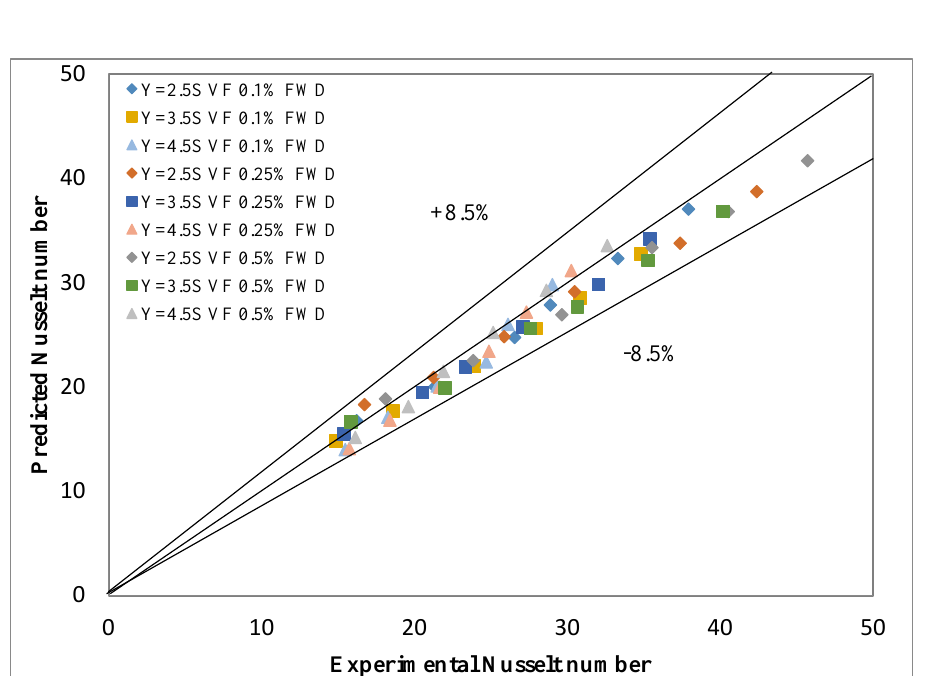
Figure 16. Predicted versus experimental Nusselt number for a staggered conical strip insert with the forward arrangement using deionized water and ZrO 2 /deionized water nanofluids under laminar flow conditions.